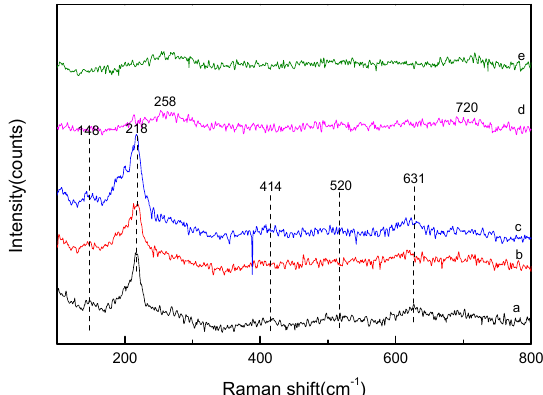
Figure 3. Raman spectra of Cu 2 O and Cu x O-Fe y O z with different Fe/Cu ratios ( a ) Cu 2 O, ( b ) CF-0.05, ( c ) CF-0.1, ( d ) CF-0.8, and ( e ) CF-2.